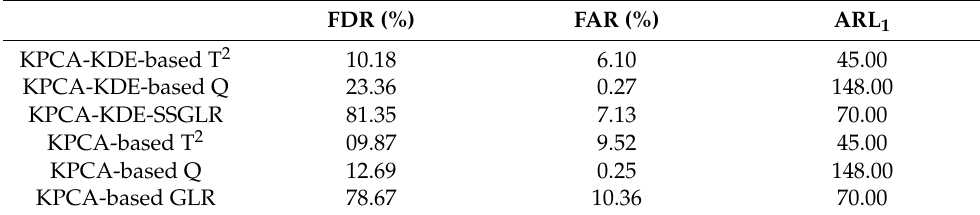
Table 2. Summary of fault detection results (TEP: IDV